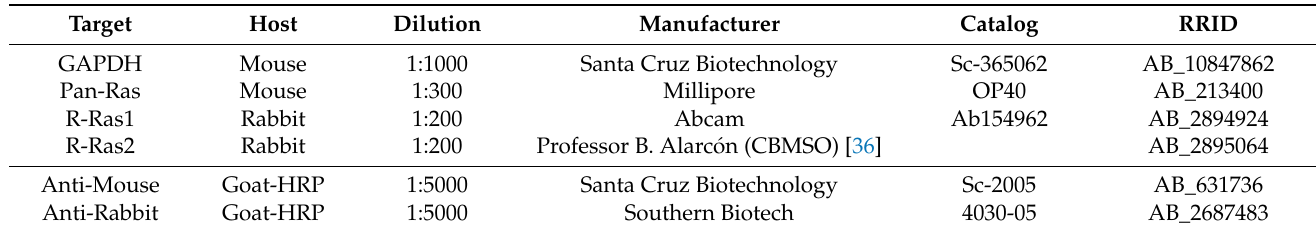
Table 3. Primary and secondary antibodies used for Western blot experiments.